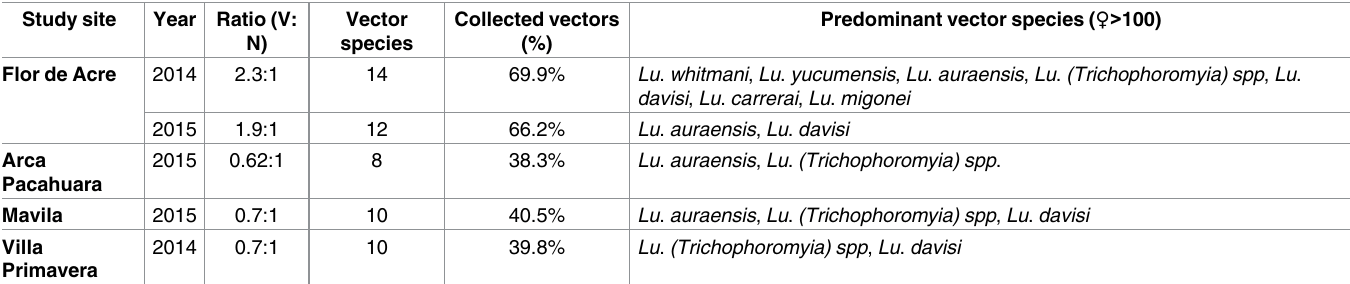
Table 1. Ratio of vectorversusnon-vector speciesper site (V:N). The tableshows the numberof different vector speciescollectedat eachstudy location, the ratio versus non-vector species and the predominant vector found at each site. Study site Year Ratio (V: Vector Collected vectors N) species